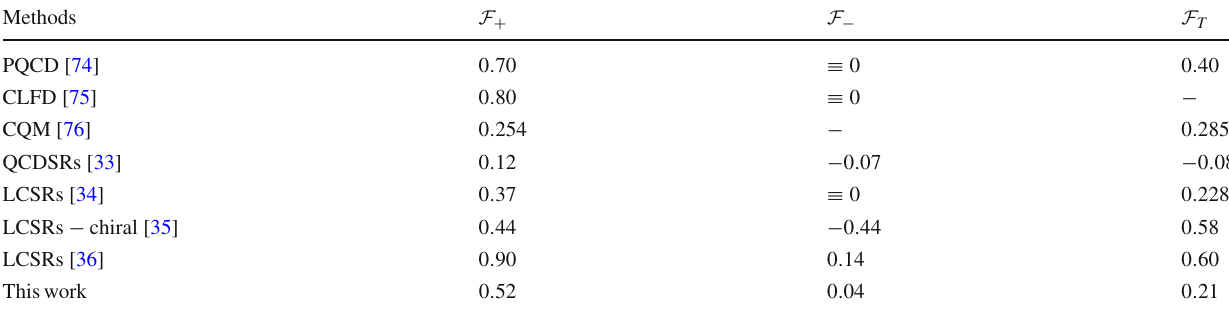
Table 1 ¯ B s → f 0 ( 980 ) form factors at q 2 = 0 ( q 2 = 4 m 2 π for [75]) predicted in different